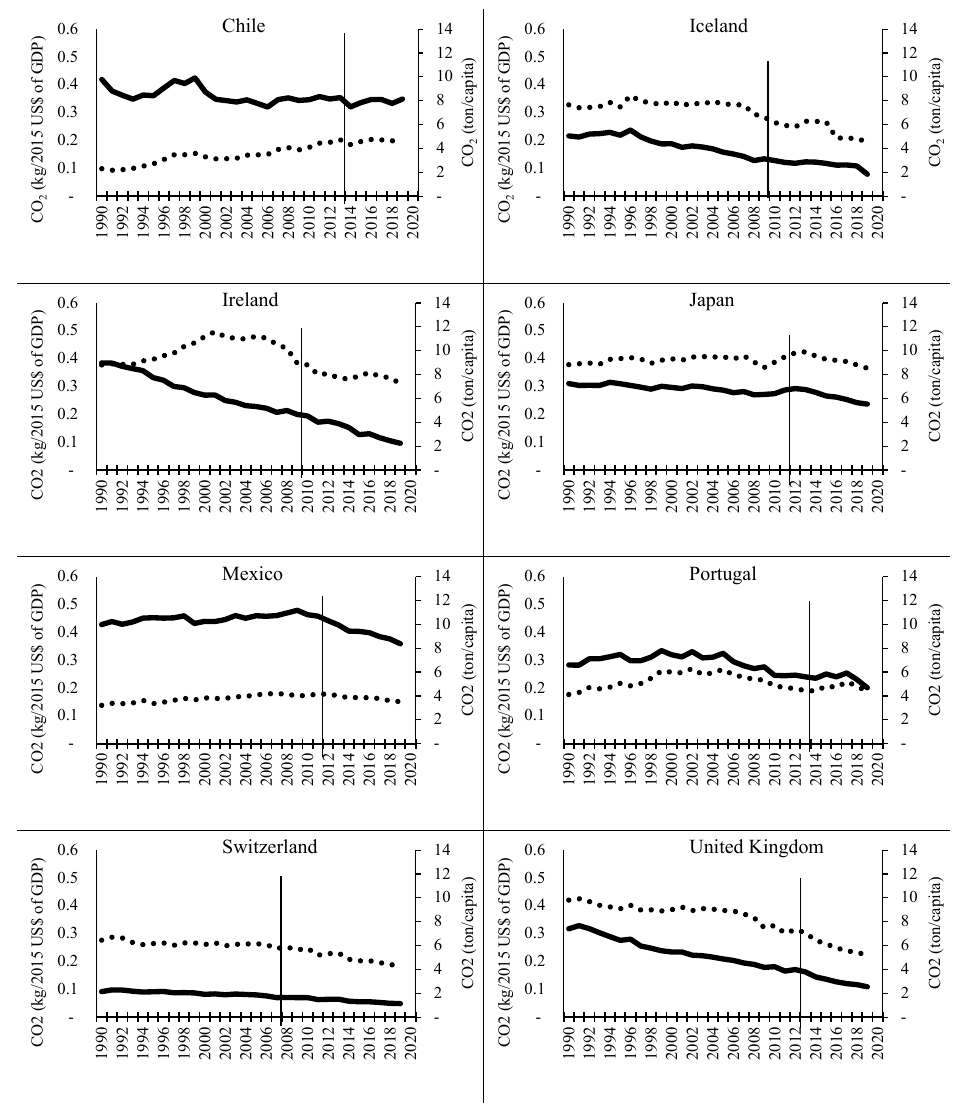
Figure 3. The effects of a carbon tax on the respective country, which had a carbon tax for ten years or less (Source: self-representation of the data from the World Bank). Table 1. Relationships from